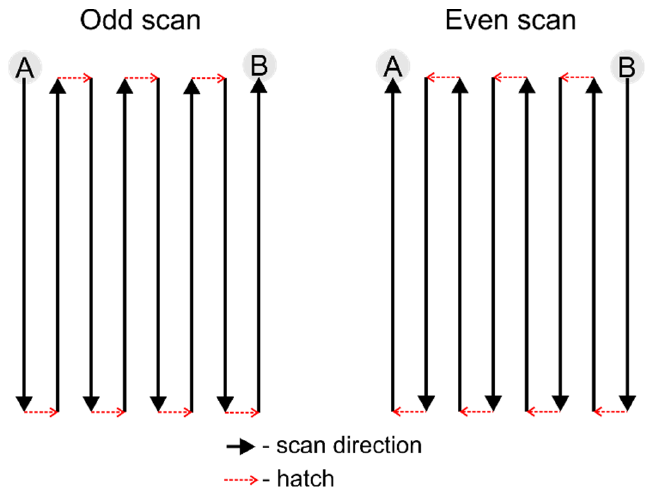
Figure 1. Graphical representation of the scan geometry used for cutting glass.